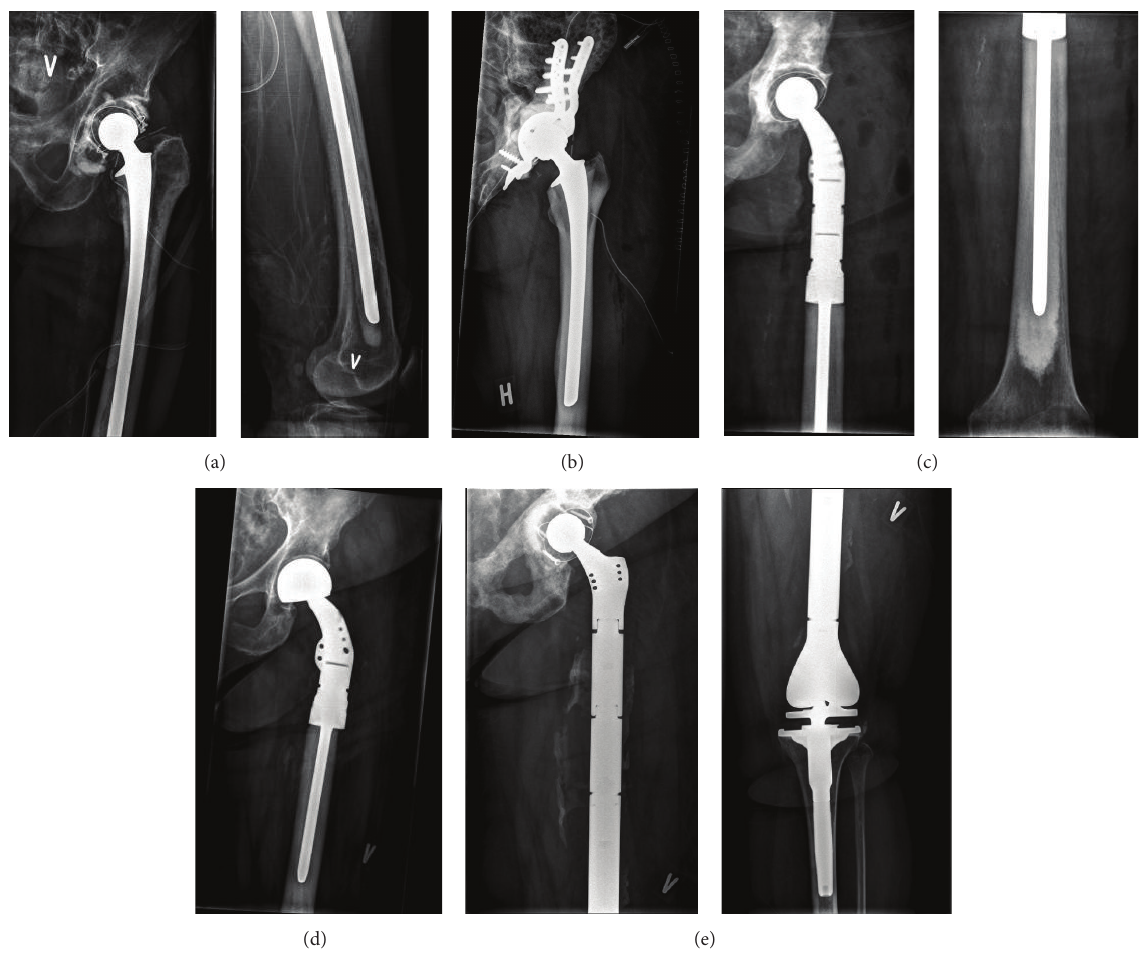
Figure1:(a)Conventionalneckresection,reconstructedwithafulllength(350 mm)cementedstandardstem(LinkSPII),tobridgemetastatic involvement of the distal femur. Note screw fixation of an antiluxation device to the cemented polyethylene cup (Link Lubinus Eccentric). (b) Conventional calcar resection, reconstructed with a cemented standard stem (Link SPII, 200 mm). Note reconstruction and